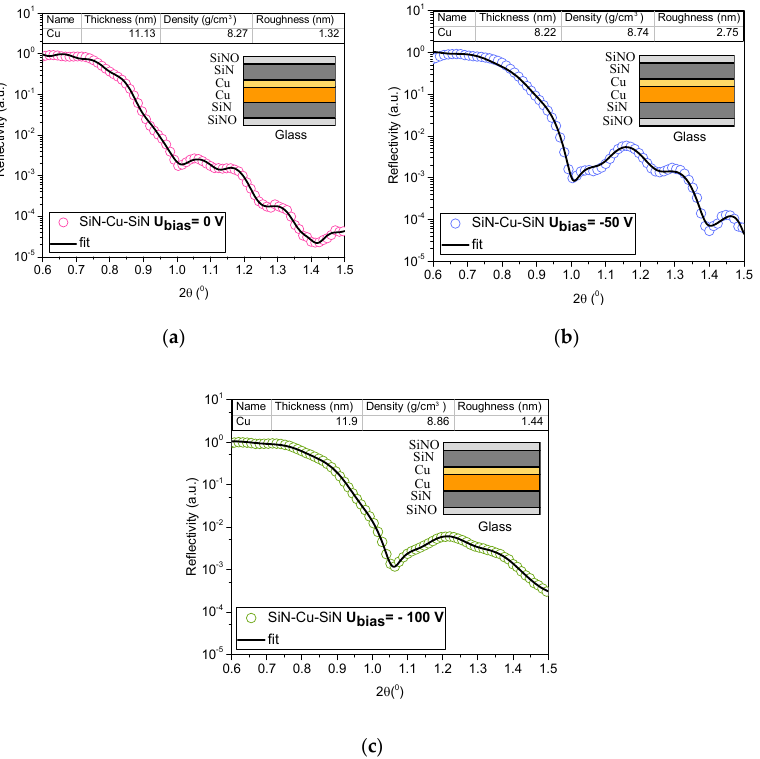
Figure 3. XRR spectra of SiN x /Cu/SiN x multilayers at the following substrate bias voltages ( a ) 0 V, ( b ) − 50 V and ( c ) − 100 V.